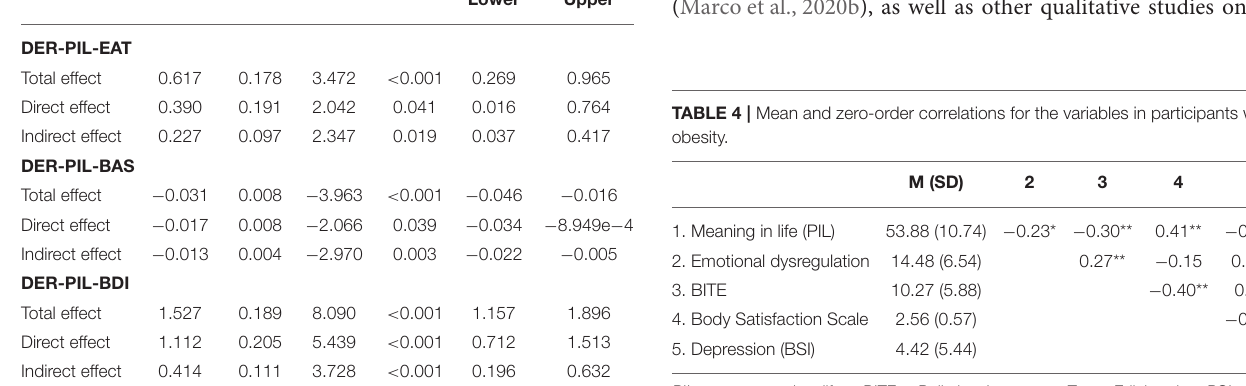
Frontiers in Psychology |